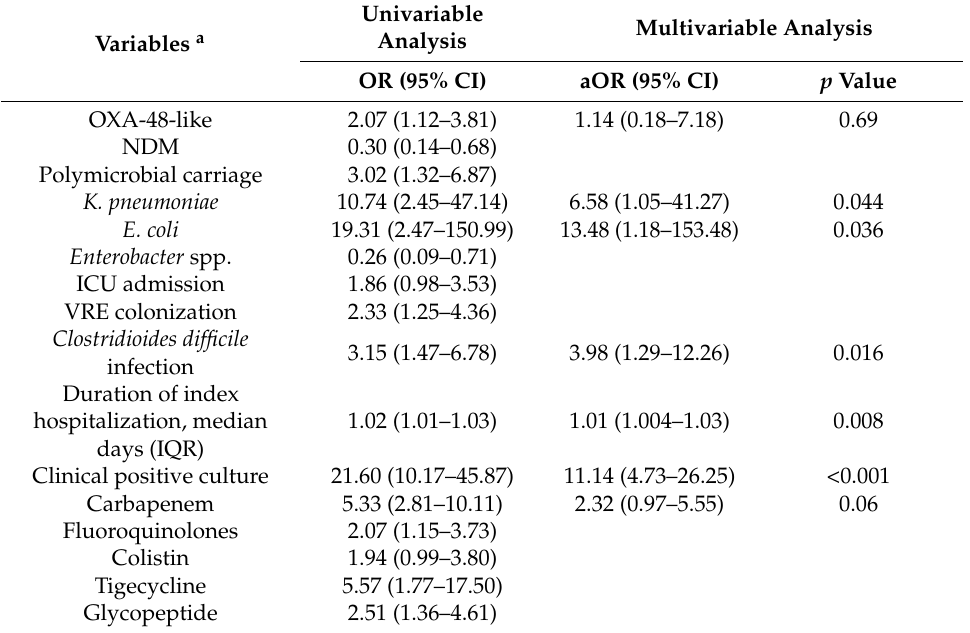
Table 2. Univariable and multivariable analyses of risk factors for prolonged carriage after 3 months among patients with carbapenemase-producing CRE